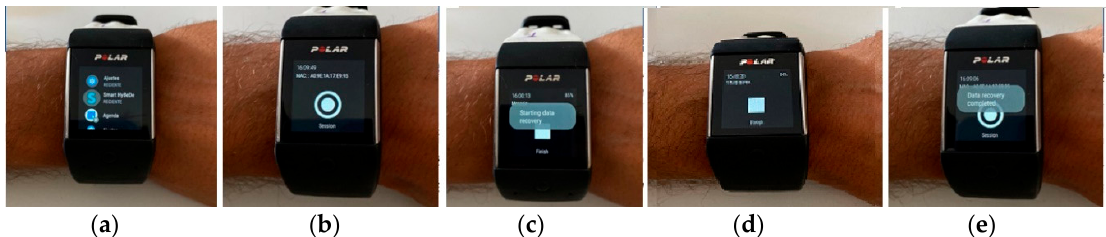
Figure 3. Proposed wearable device, Polar M600, showing: ( a ) the Android Wear application, ( b ) start button to collect the acceleration, gyroscope, and heart rate data, ( c ) start of data collection in the files, ( d ) number of saved files according to the duration of the session, and ( e ) end of session and file